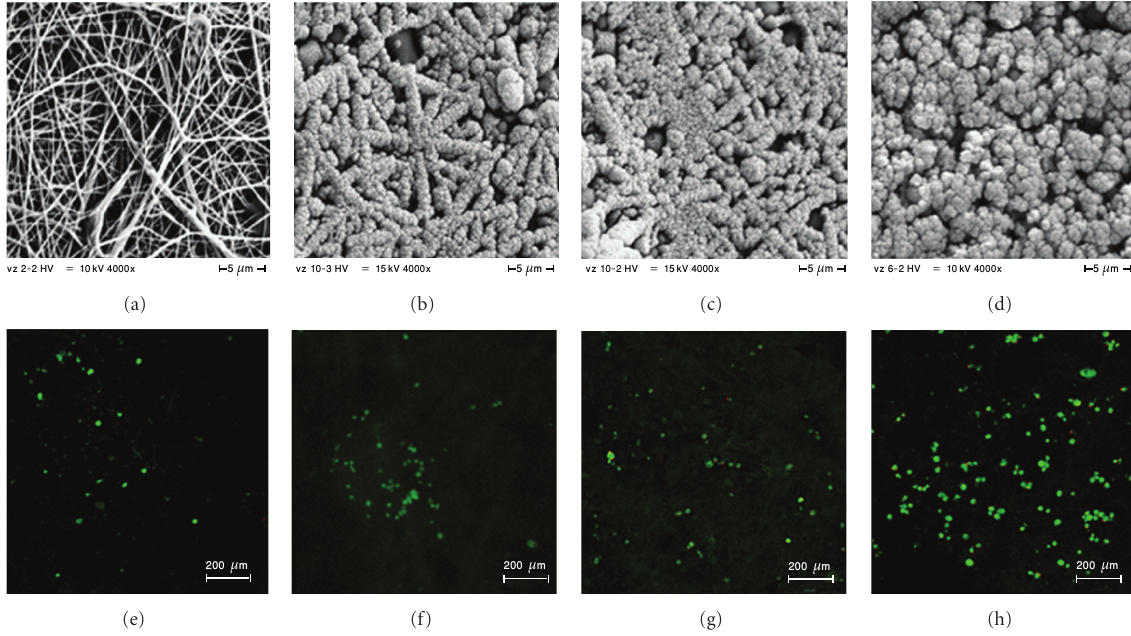
Figure 1: Visualization of sca ff olds by SEM and confocal microscopy. Prepared sca ff olds were visualized using SEM (a, b, c, d). On day 7, MSCs were stained using BCECF-AM and propidium iodide for live/dead staining, and samples were visualized by confocal microscopy (e, f, g, h); PCL/PVA (a, e), PCL/PVA200HA (b, f), PCL/PVA400HA (c, g), and PCL/PVA800HA (d,